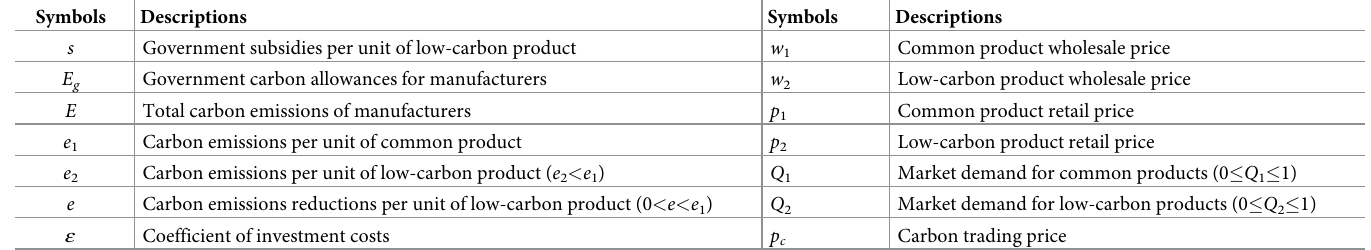
Table 1. List of symbols and descriptions in the model. Symbols Descriptions